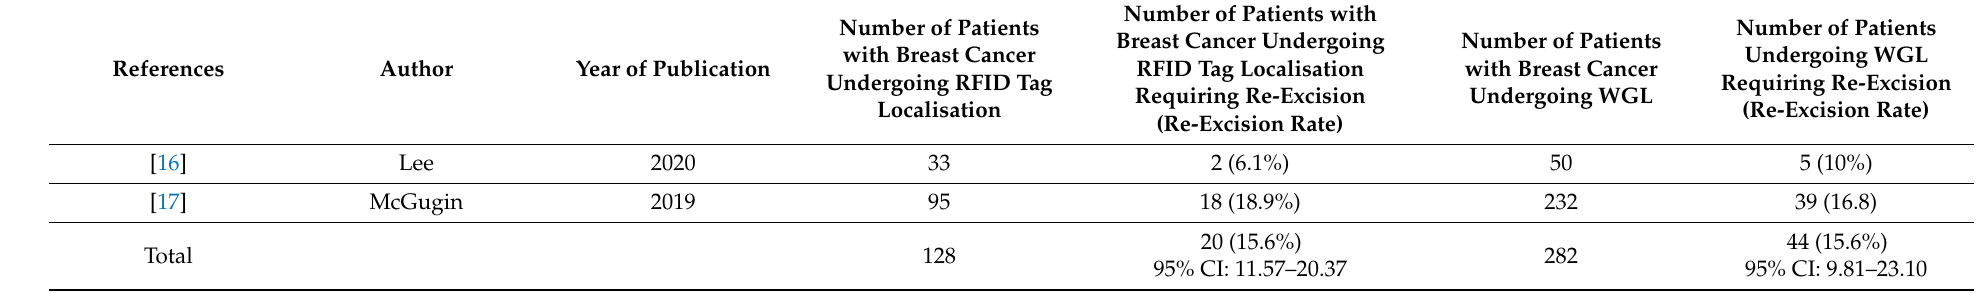
Table 2. Details of studies included in pooled analysis comparing re-excision rate between radio-frequency identification (RFID) tag localisation and wire-guided localisation (WGL). (Chi-squared test, p =